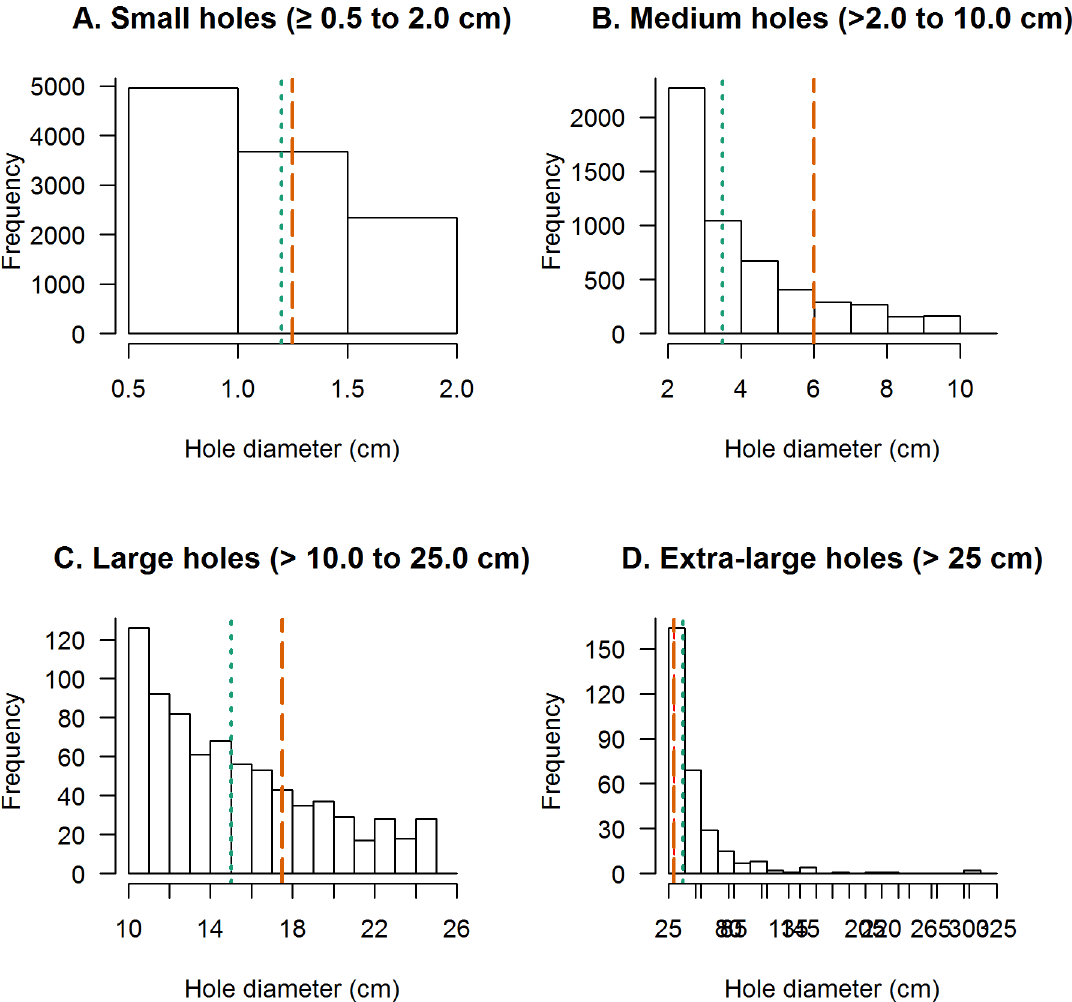
Fig 2. Histogram of measured hole diameters for each assigned WHOPES hole category. The midpoint hole diameter used for the WHOPES category weight is indicated by an orange dashed vertical line. The median hole diameter in each category is indicated by a green dotted vertical line.